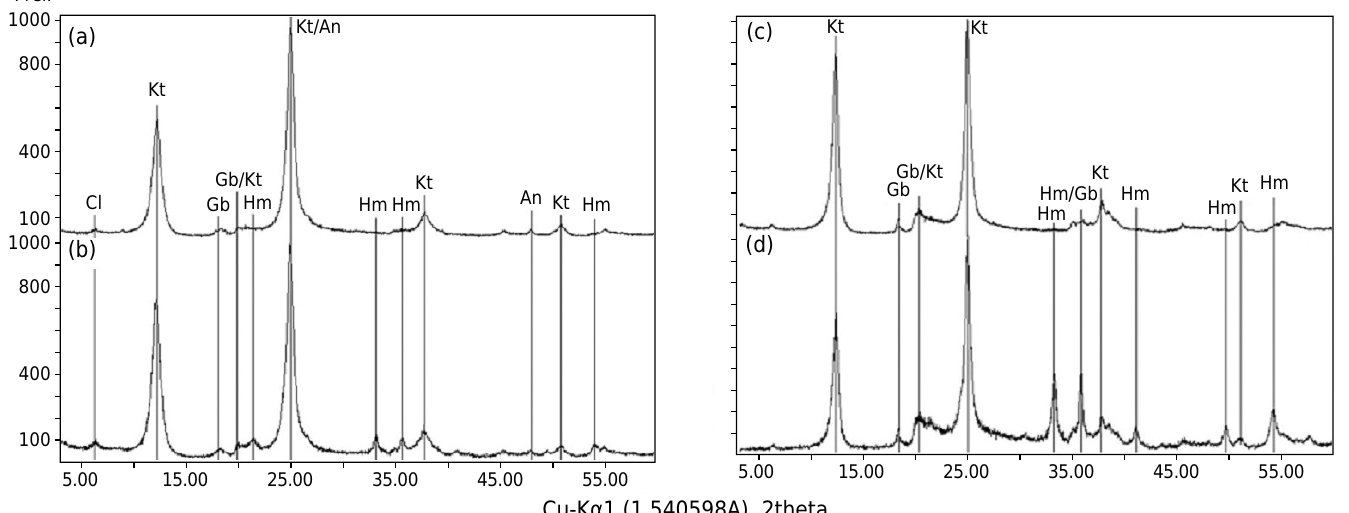
Figure 2. X-ray diffraction of the clay fraction from the layer of 0.00-0.20 m treated with (a and c) and without (b and d) citrate- bicarbonate-dithionate (CBD). Figures (a) and (b) are related to Agudos and figures (c) and (d) are related to Macatuba. An = anatase; Cl = chlorite; Gb = gibbsite; Hm = hematite; Kt =